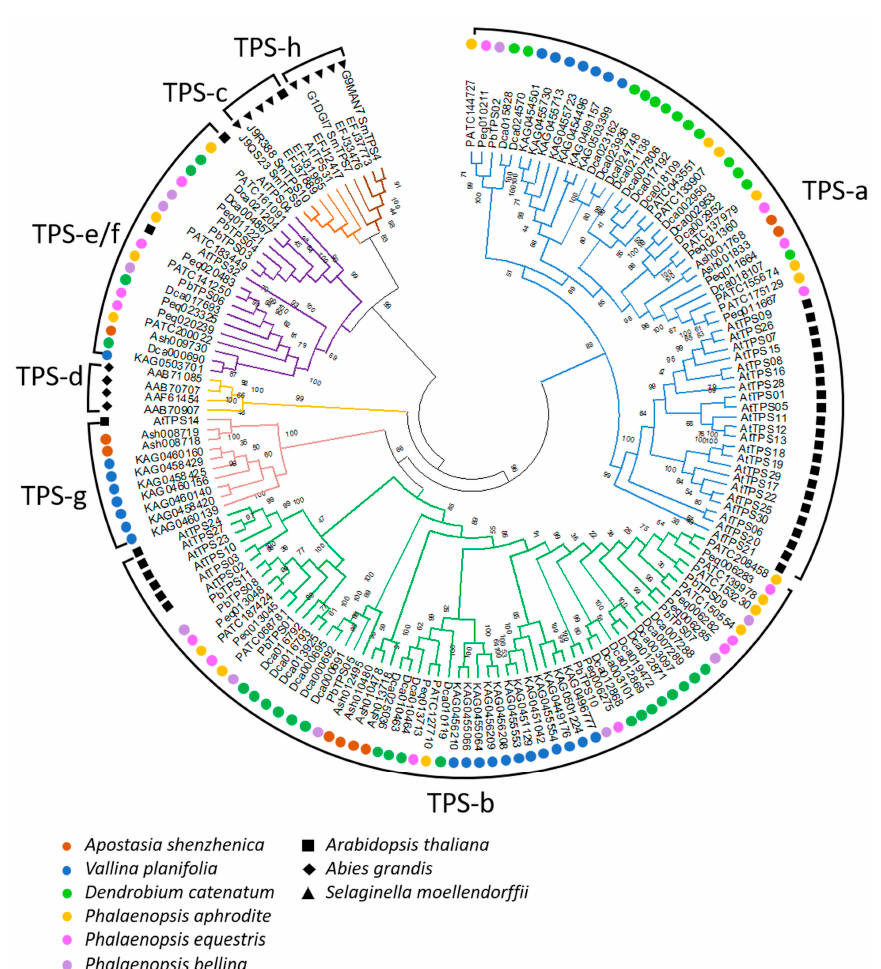
Figure 2. Phylogenetic analysis of terpene synthases. TPSs in Orchidaceae, including A. shenzhenica ; V. planifolia ; D. cate- natuml P . equestris Phalaenopsis aphrodite; P. bellina , Arabidopsis thaliana , and Abies grandis; and S. moellendorffii were